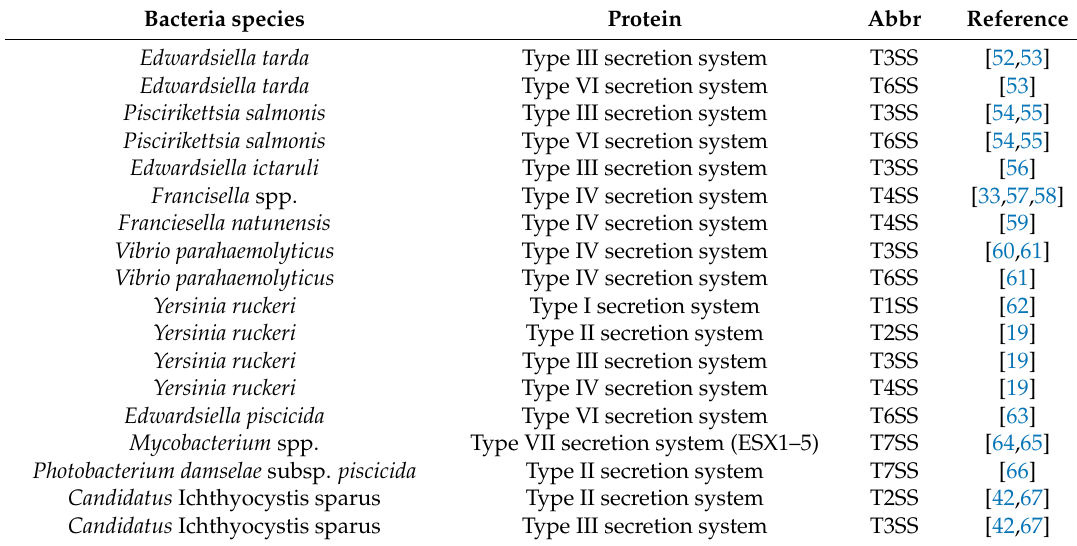
Table 2. Secretion system proteins for intracellular bacteria trafficking fish